Question: According to this chart, does the measure grow or shrink?
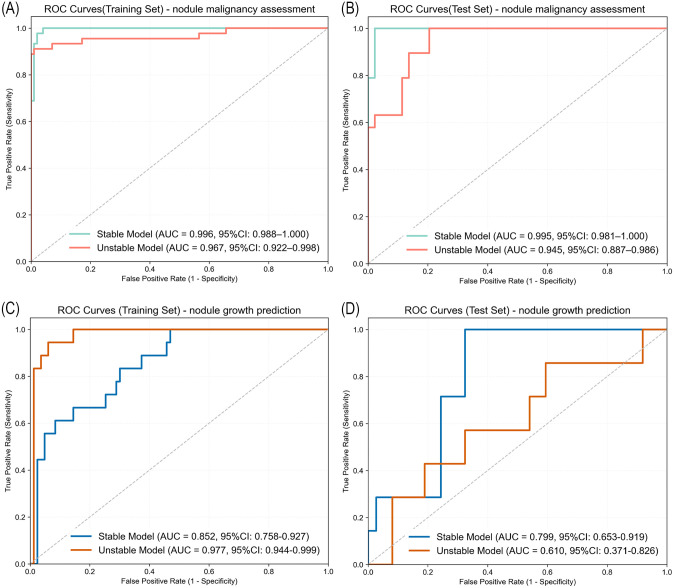
Answer: increasing